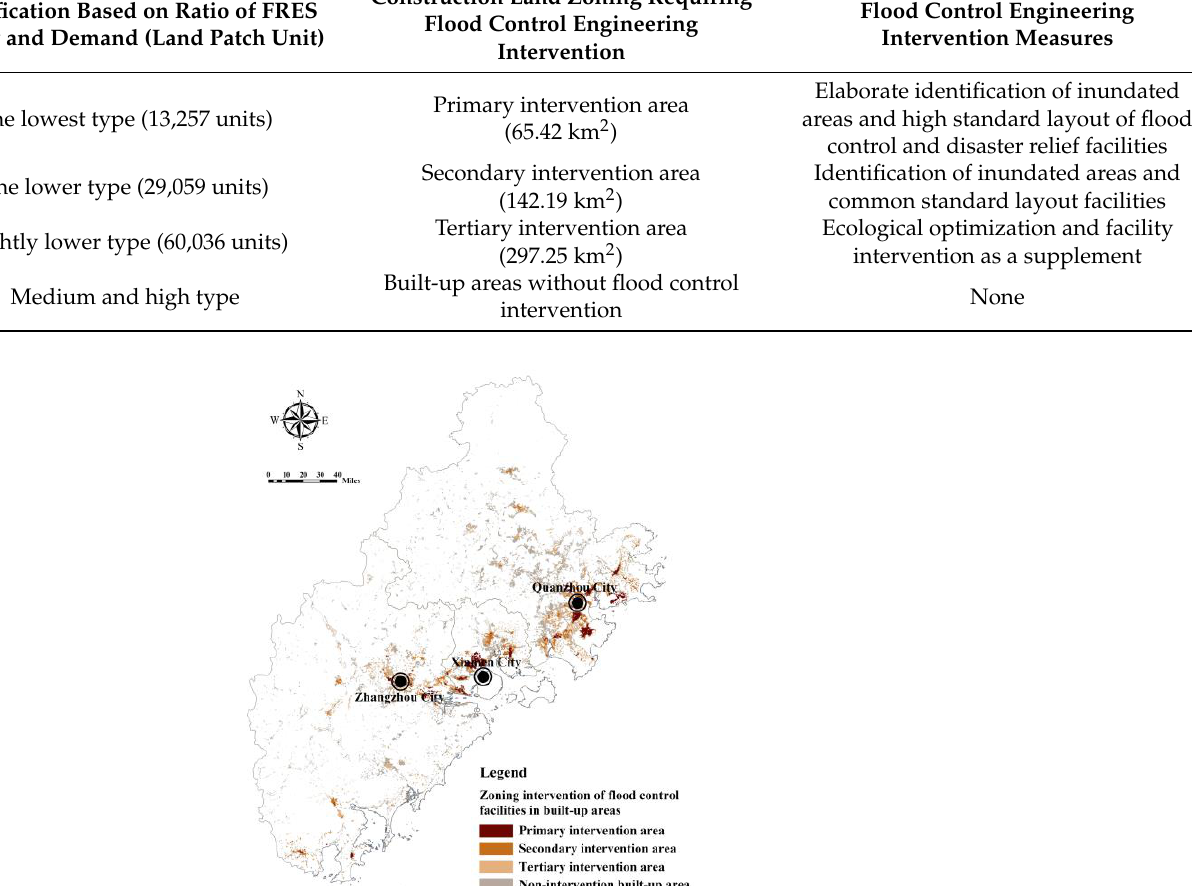
Table 5. Intervention zoning of flood control projects in the Fujian Triangle built-up area based on the ratio of FRES supply and demand in land patches.